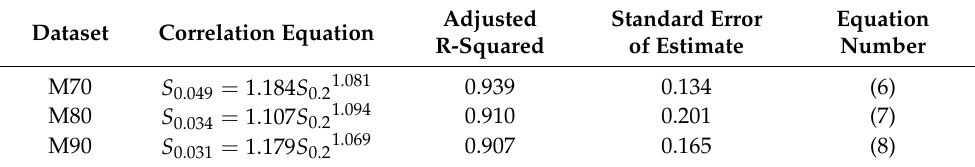
Table 9. Correlation equations between S λ and S 0.2 for M70, M80 and M90 decadal datasets. Dataset